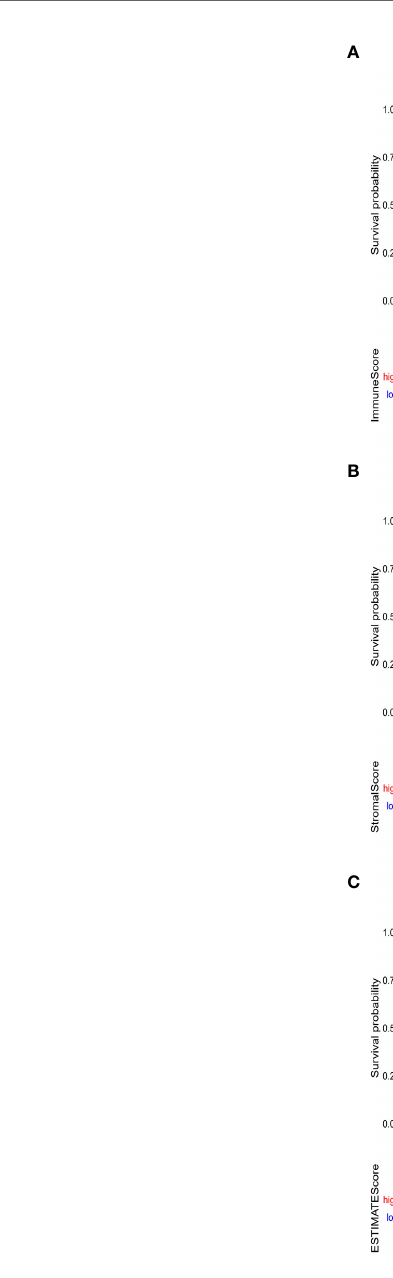
FIGURE 2 | Associations of ImmuneScore, StromalScore, and ESTIMATEScore with survival among BRCA patients. Kaplan – Meier survival analyses of BRCA patients with low and high (A) ImmuneScores ( p = 0.011), (B) StromalScores ( p = 0.674), and (C) ESTIMATEScores ( p =